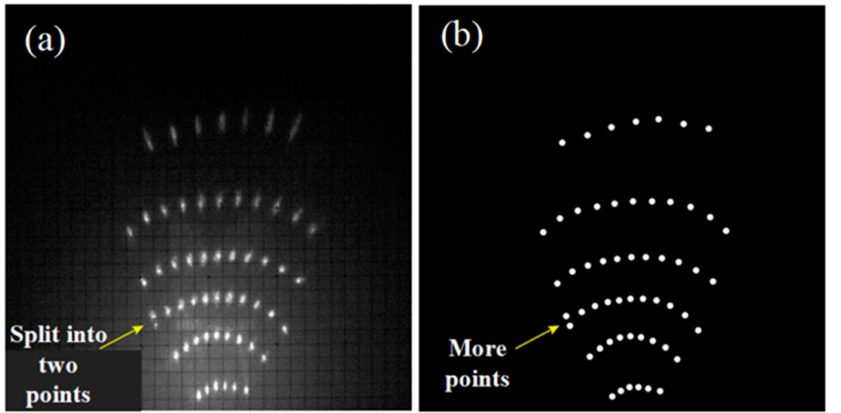
Figure 11. More points phenomenon caused by splitting of imaging points. ( a ) A reflection image taken in a 70 A current test; ( b ) the image processing result of ( a ).